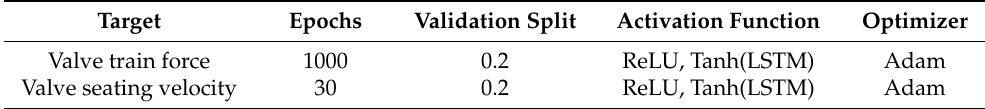
Table 3. Hyperparameters used in the deep learning-based prediction